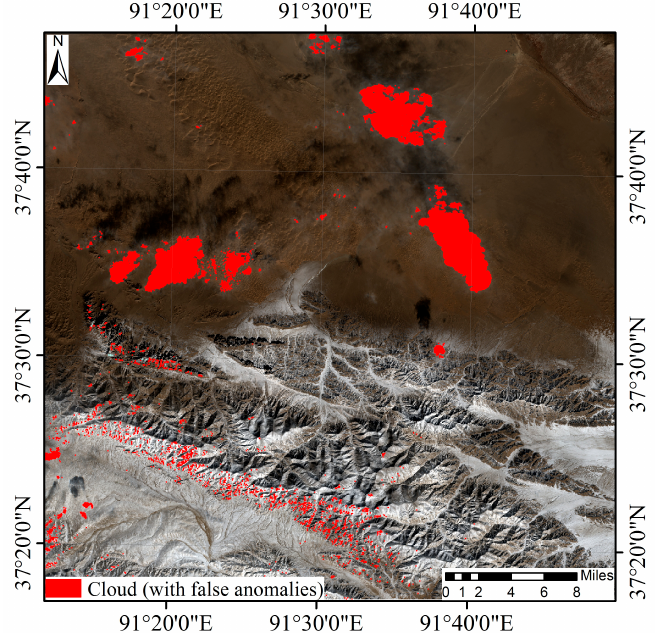
Figure 6. Output image of the anomaly-overlaying between ROI 1 and ROI 2.